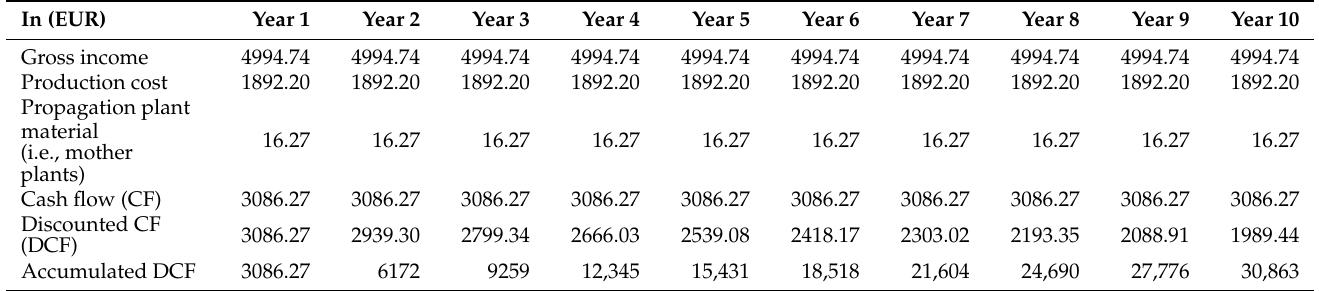
Table 14. Economic analysis (in EUR) associated with the conventional production model (CM) for Abelia grandiflora .